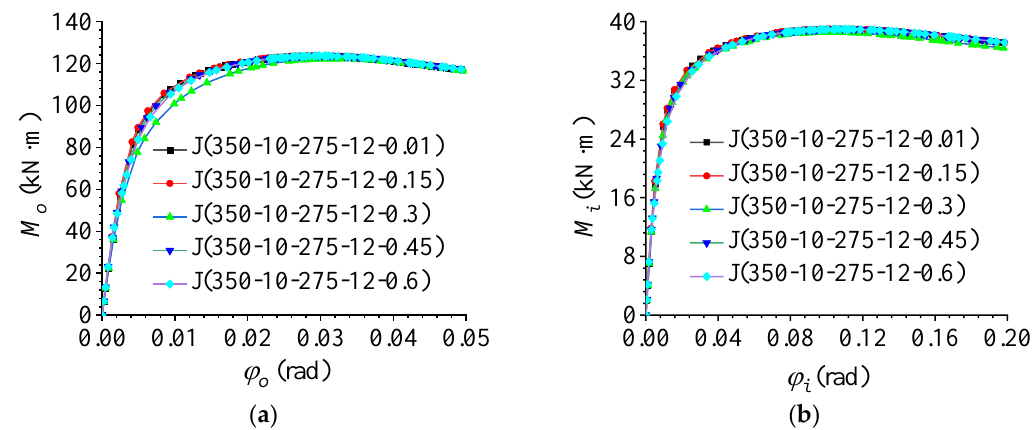
Figure 19. Effect of the bolt pretension force. ( a ) Out-of-plane M–φ curve; ( b ) in-plane M–φ